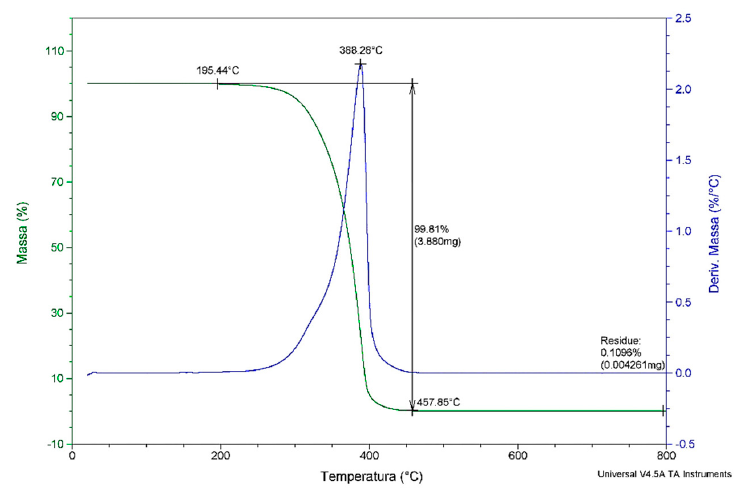
Figure 3. Thermogravimetry / derivate thermogravimetry (TGA / DTG). Curves of Caryocar brasiliense oil.